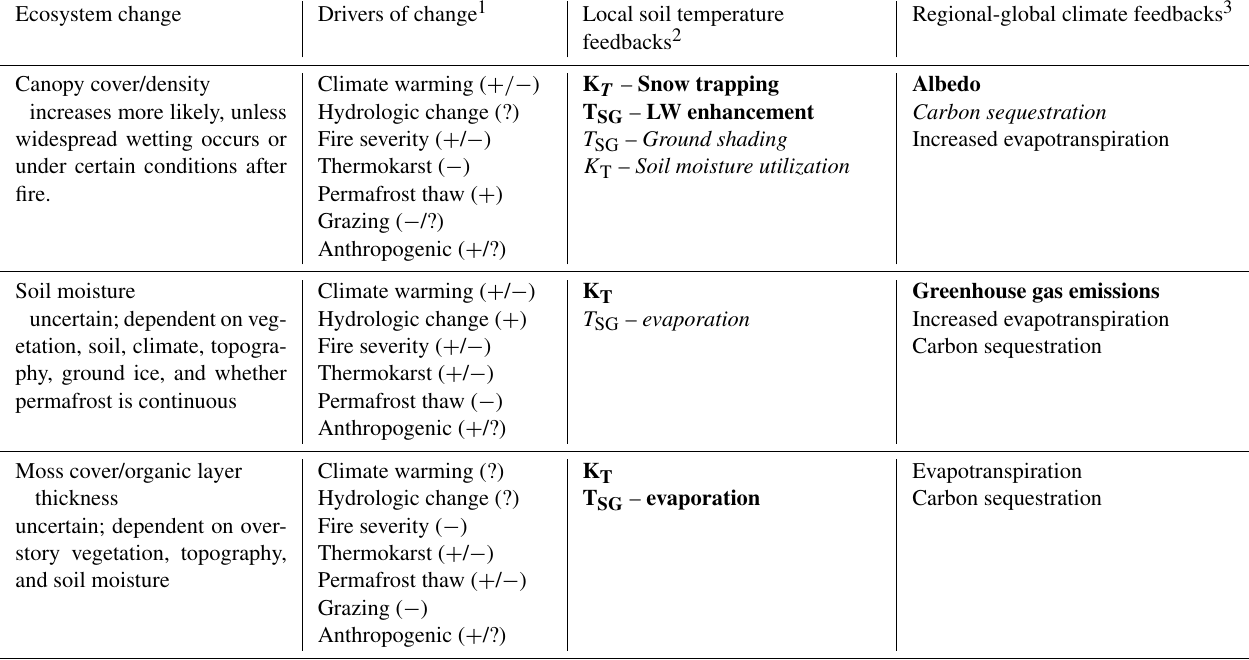
Table 1. Key ecosystem changes, associated drivers, and feedback effects on local soil climate and regional to global climate. Ecosystem change Canopy